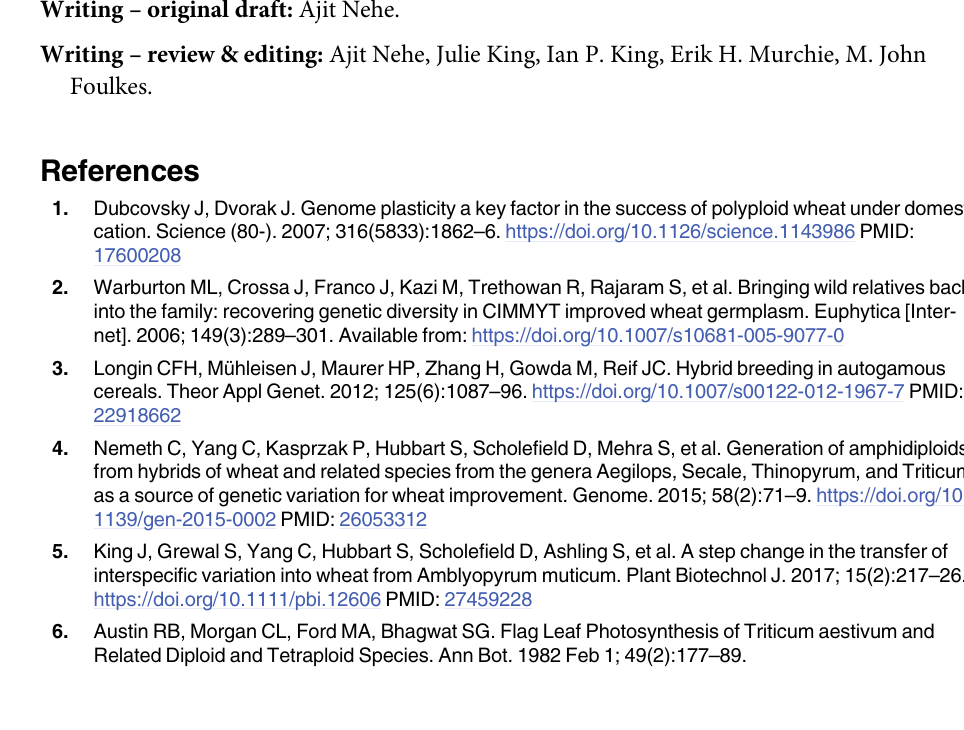
S3 Table. N-utilization efficiency for plant (PL NUtE), above-ground N per plant